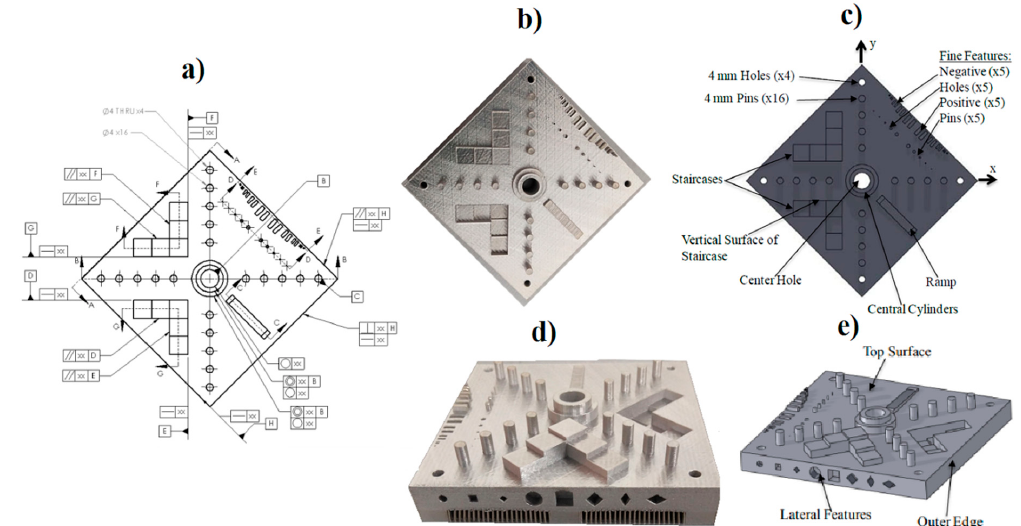
Figure 2. Supported and non-supported NIST test artifact, technical drawing and 3D model of the test artifact used in the SLM and coordinate-measuring machines [13]. ( a ) exhibits the technical drawing and dimensional tolerances. ( b , d ) show the supported NIST test artifact and ( c , e ) exhibit the main features of the 3D designed NIST test artifact.